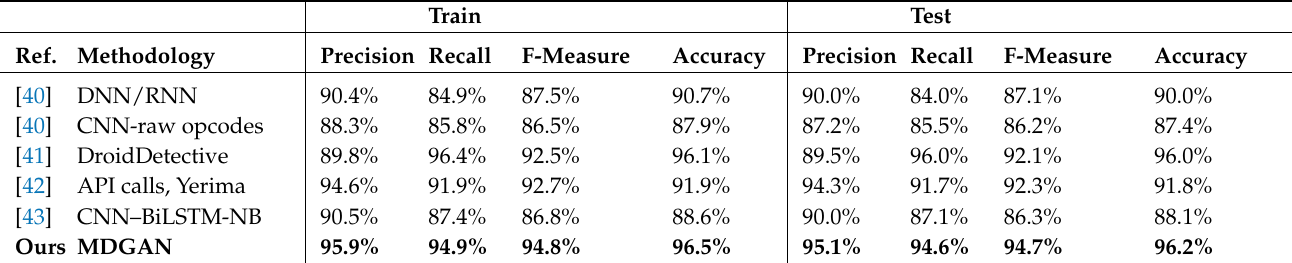
Table 4. Comparison with state-of-the-art methods.